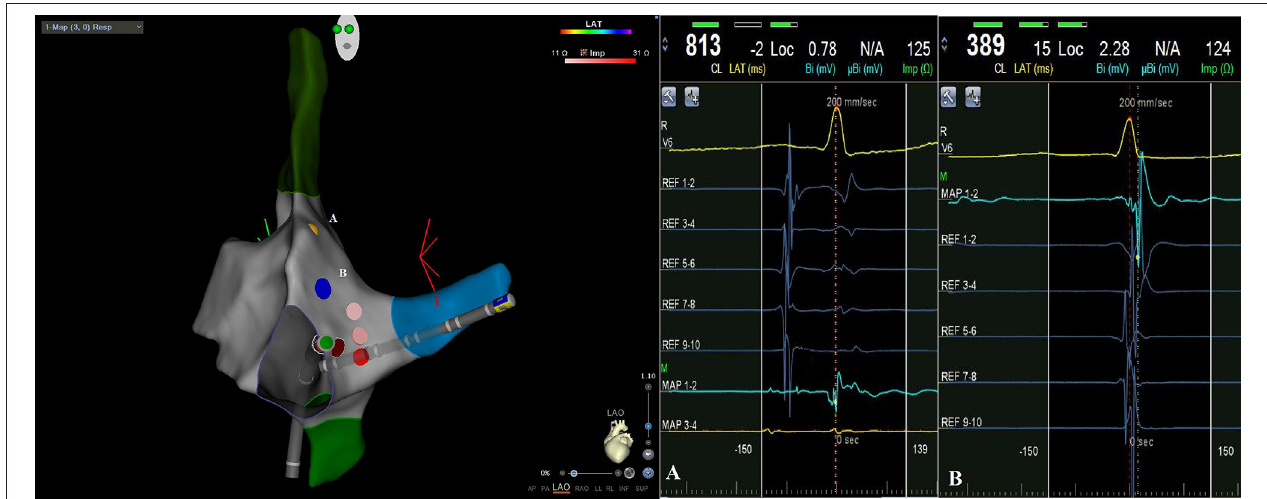
FIGURE 1 | CARTO3 left anterior oblique (LAO) image of atrioventricular nodal reentrant tachycardia ablation: during radiofrequency applications catheter remains below tagged His potential [yellow point A on EAM, intracavitary signal (A) ] and fast way potential [blue point B on EAM, intracavitary signal (B)